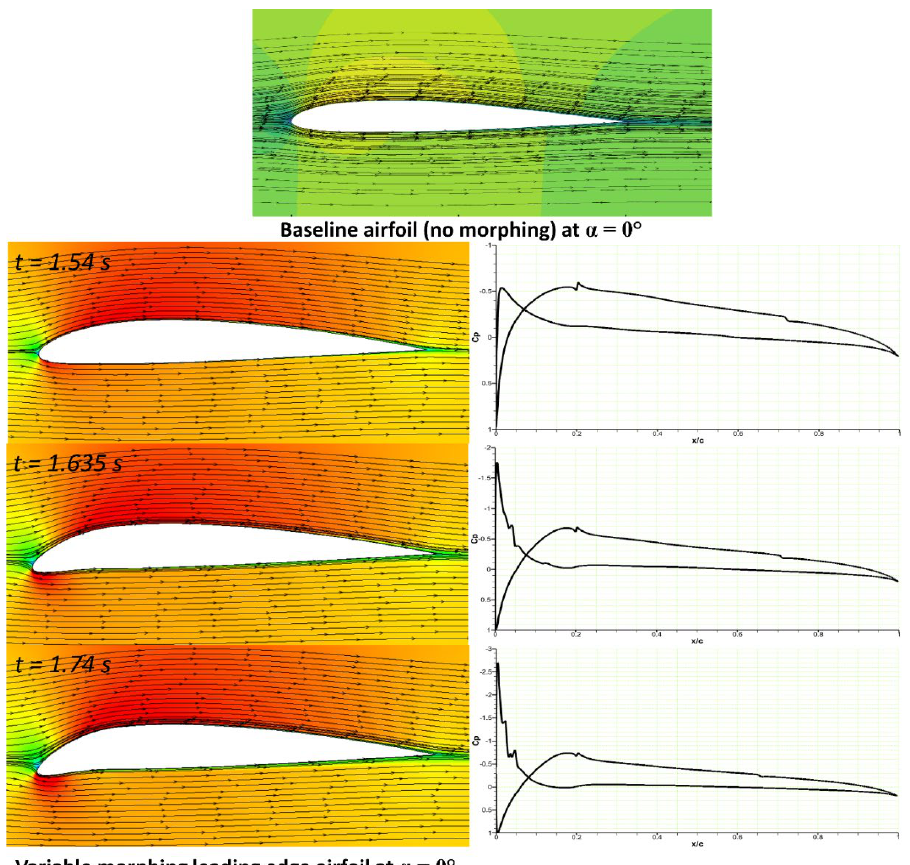
Figure 11. Streamline velocity contours at different time steps in a variable morphing leading edge and the Cp distribution at 0° angle of attack.